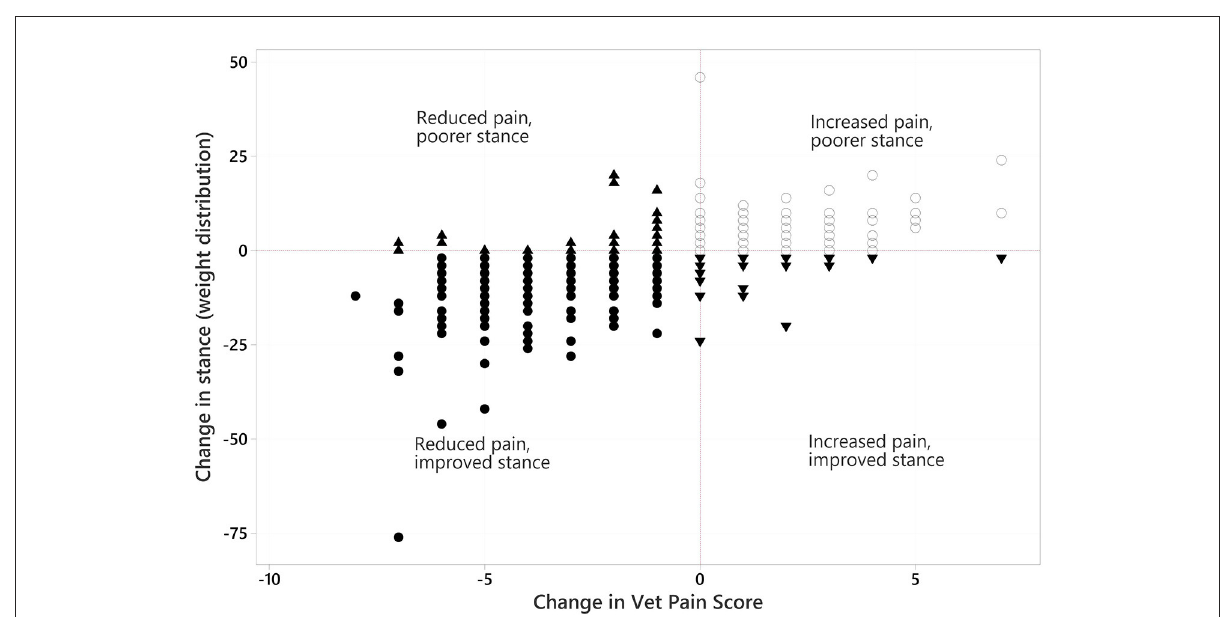
FIGURE11 Scatter of changes in stance (weight distribution) plotted against changes in vet-assessed pain score. In each variable negative values reflect an overall improvement. Different symbols are used merely to indicate dogs in combinations of the improved/not improved categories of both